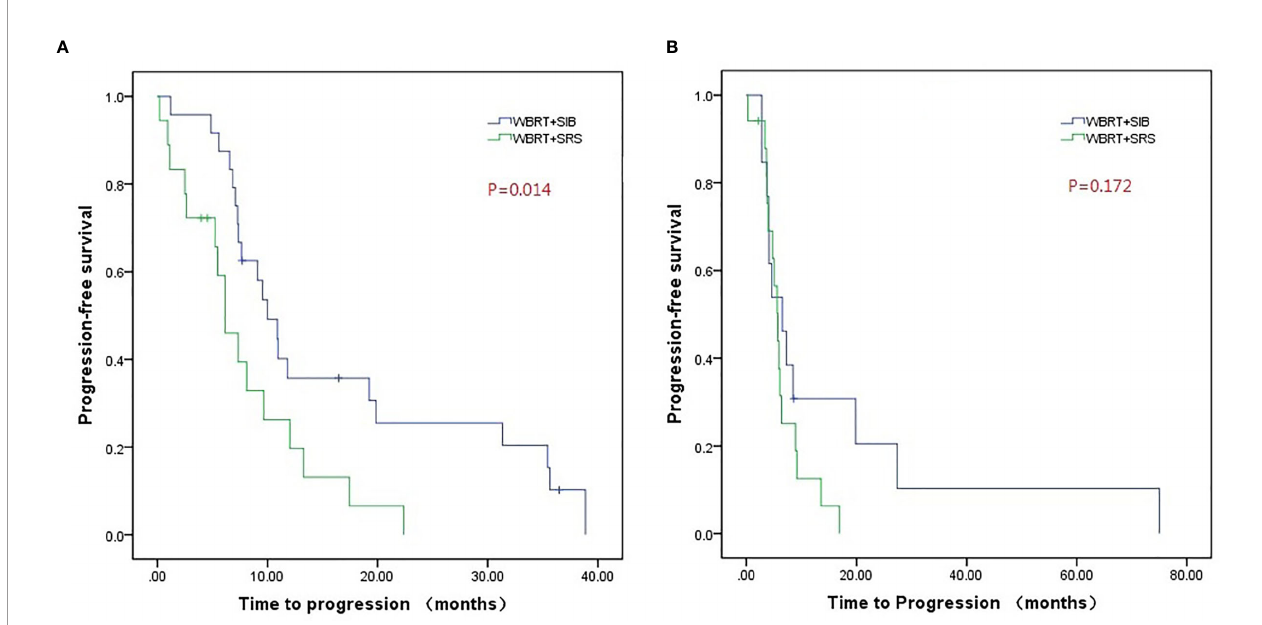
FIGURE 4 | Compared intracranial progression-free survival of WBRT + SRS and WBRT + SIB in male (A) or female (B) patients.